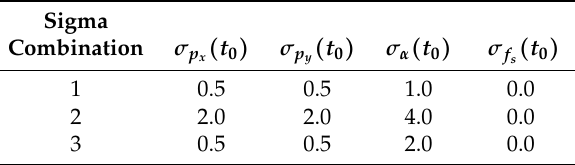
Table 6. Varied sigma values for the SCs.